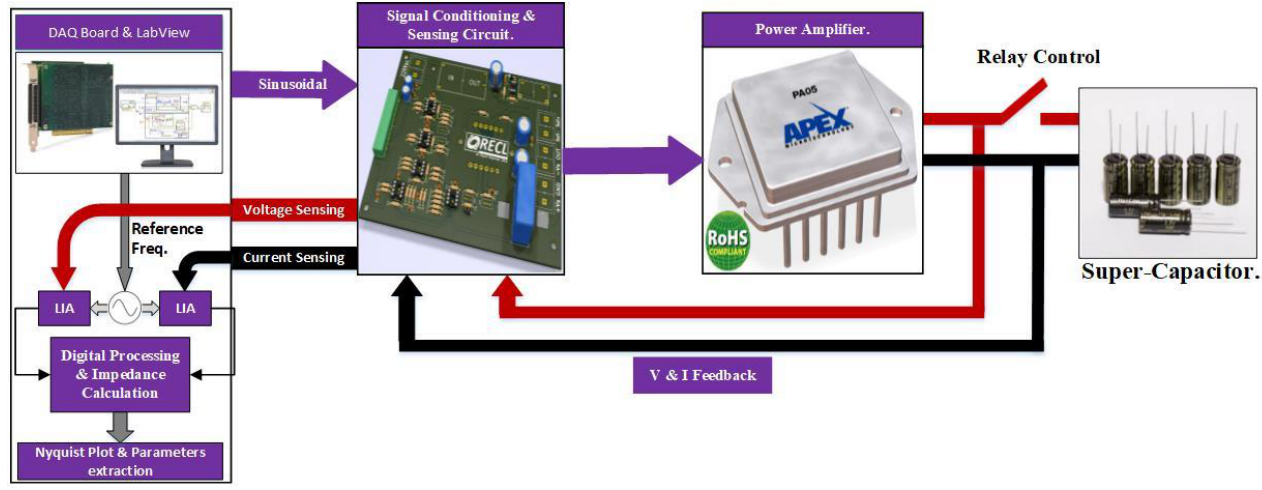
Figure 6. Block diagram of the proposed system.